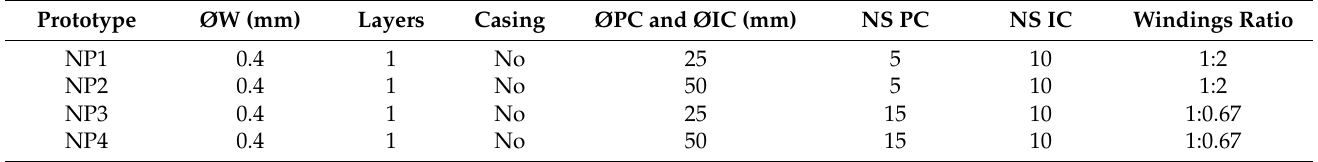
Table 2. Features of the prototypes NP1 to